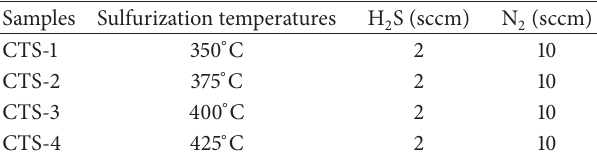
Table 2: EDX of the Cu